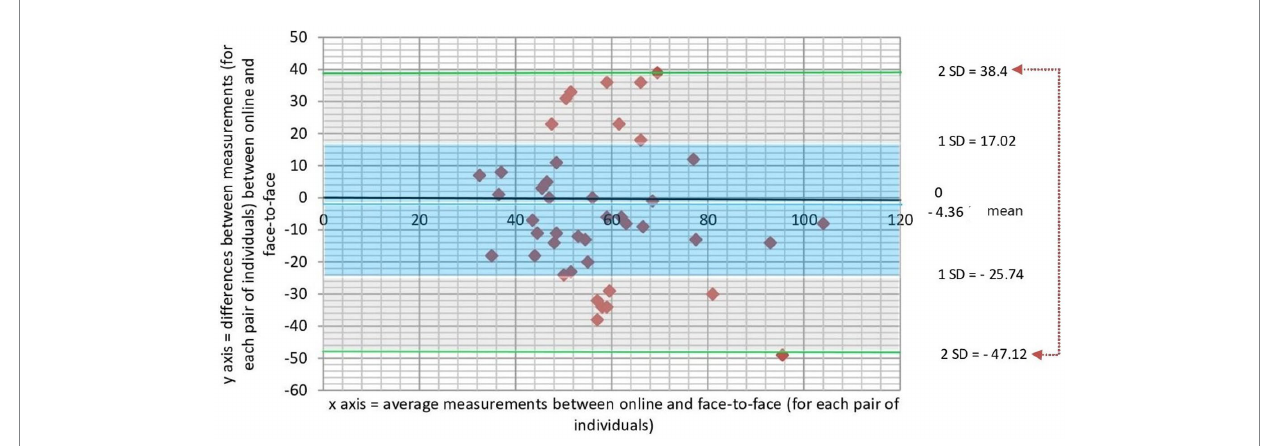
FIGURE 4 Scatter plot showing the relationship between magnitude of difference and size of measurement for the VRT variable measured online and face to face in the same subject. The difference between the paired measurements is plotted on the vertical-axis and average of the measures of two modalities (online and face-to-face) on the horizontal-axis. The mean difference in values obtained with the two modalities (bias) is represented by a central horizontal line on the plot. Horizontal lines above and below the central horizontal line represent the 95% limits of agreement (LOA—upper and lower LOA). A priori defined clinical criteria considered clinically relevant differences those that are greater than 20 ms. Note that all values are between ±2 SD from the mean, and more than 70% of values are within ±1SD from the mean. VRT, variability of reaction time.